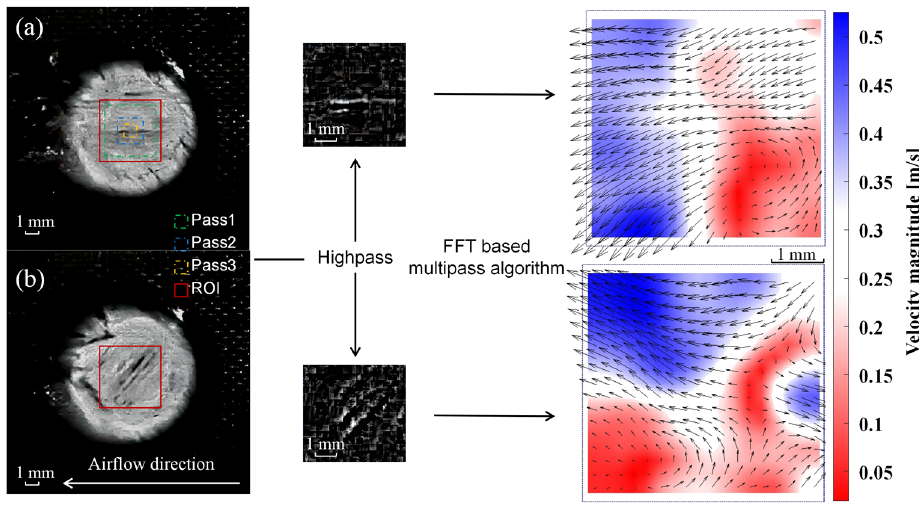
Figure 2. The flowchart of PIVlab analysis and results of velocity distribution. ( a ) Laser irradiation time is 0.8 s; ( b ) Laser irradiation time is 1.2